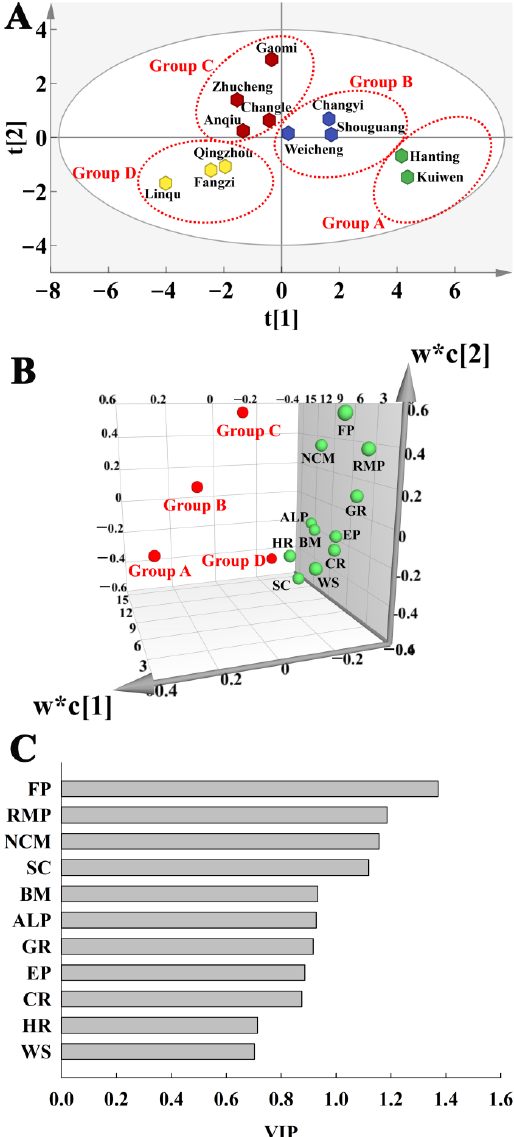
Figure 4. Score scatter plot ( A ), loading scatter plot ( B ), and the value of variable importance in projection (VIP) ( C ). Note: t[1] indicates the score of the first principal component; t[2] indicates the score of the second principal component; w*c[1] indicates the first loading coefficient; w*c[2] indicates the second loading coefficient; FP indicates food production; RMP indicates raw material production; NCM indicates nutrient cycle maintenance; SC indicates soil conservation; BM indicates biodiversity maintenance; ALP indicates aesthetic landscape provision; GR indicates gas regulation; EP indicates environment purification; CR indicates climate regulation; HR indicates hydrology regulation; and WS indicates water